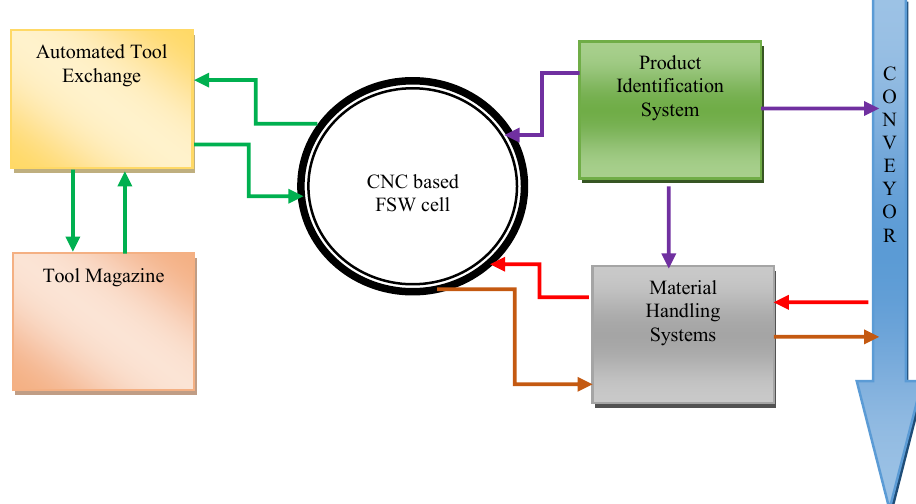
Fig. 2 CNC based Friction Stir Welding Cell Operation